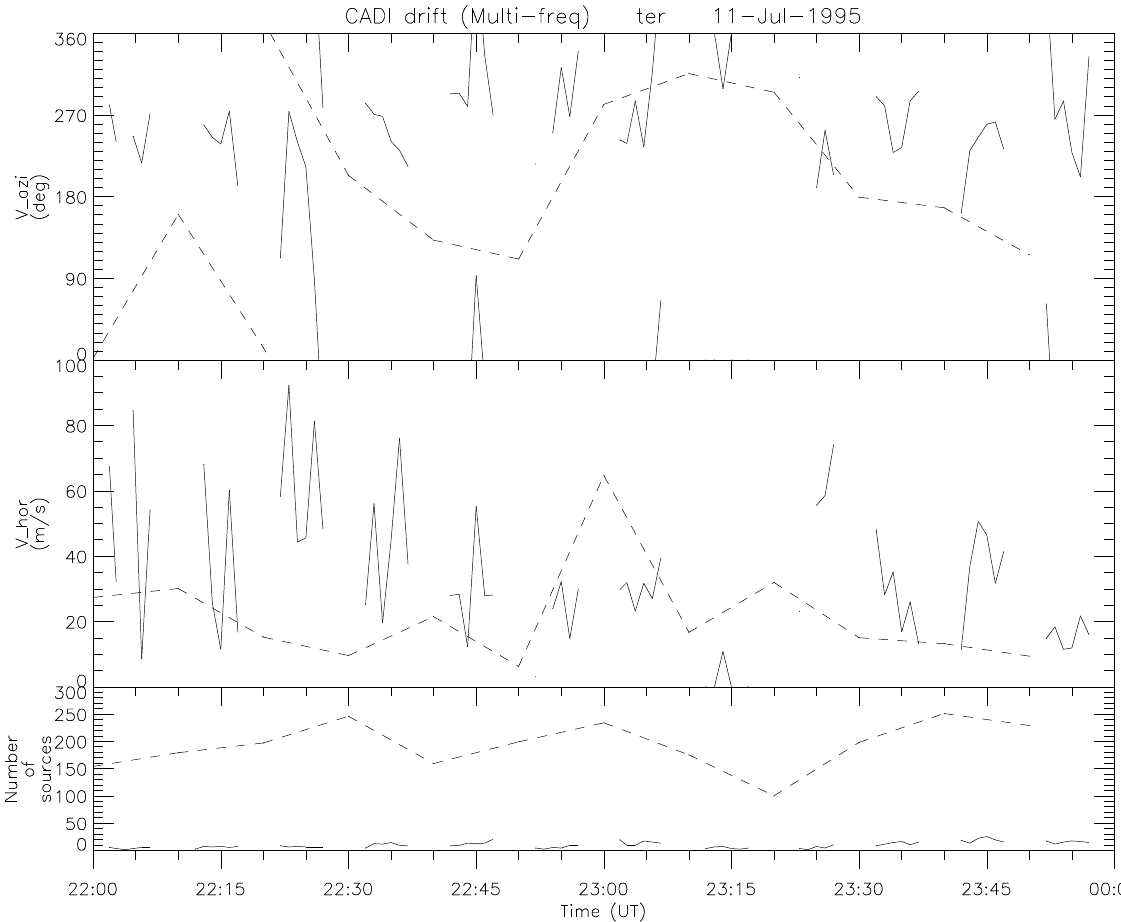
Fig. 4. CADI drift analysis from the same time period as presented in Figs. 2 and 3. Again, the period of interest is 22:30 to 23:30 UT on 11 July 1995. The solid lines represent the fixed frequency mode drift analysis and the dashed lines represent the ionogram mode drift